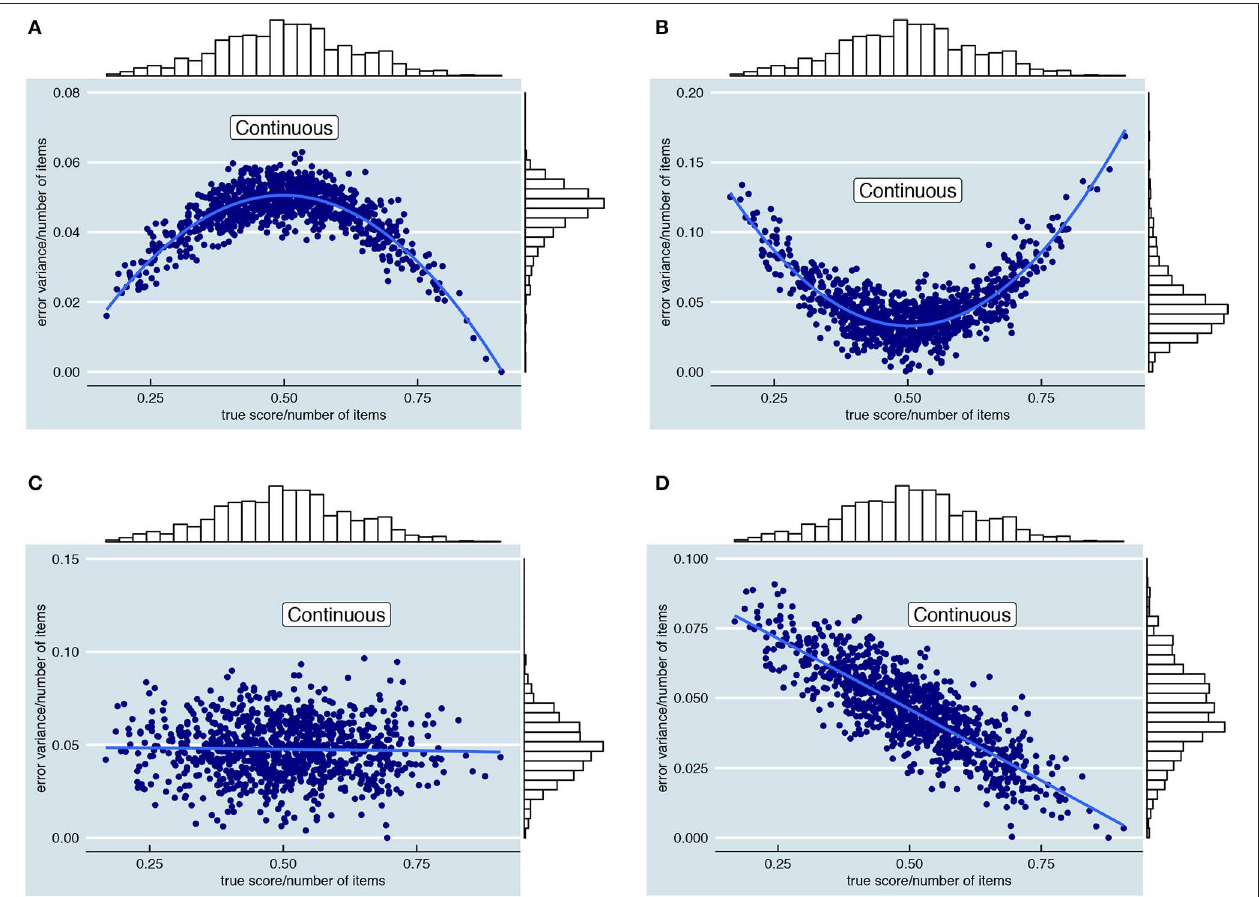
FIGURE 5 | Visualization of the four simulated relationships between “true” total test score (x-axis) and error variance (y-axis). Each dot represents one of the 1,000 fictional examinees. To ease comparison, the error variance and the true score are divided by the number of items in the plots. Note that the y-axis scale depends on the chosen level of reliability. (A) Quadratic relationship between true score and error variance, with lower error variances for examinees with extreme true scores. (B) Quadratic relationship between true score and error variance, with higher error variances for examinees with extreme true scores. (C) Absence of a relationship between true score and error variance. (D) Linearly decreasing relationship between true score and error